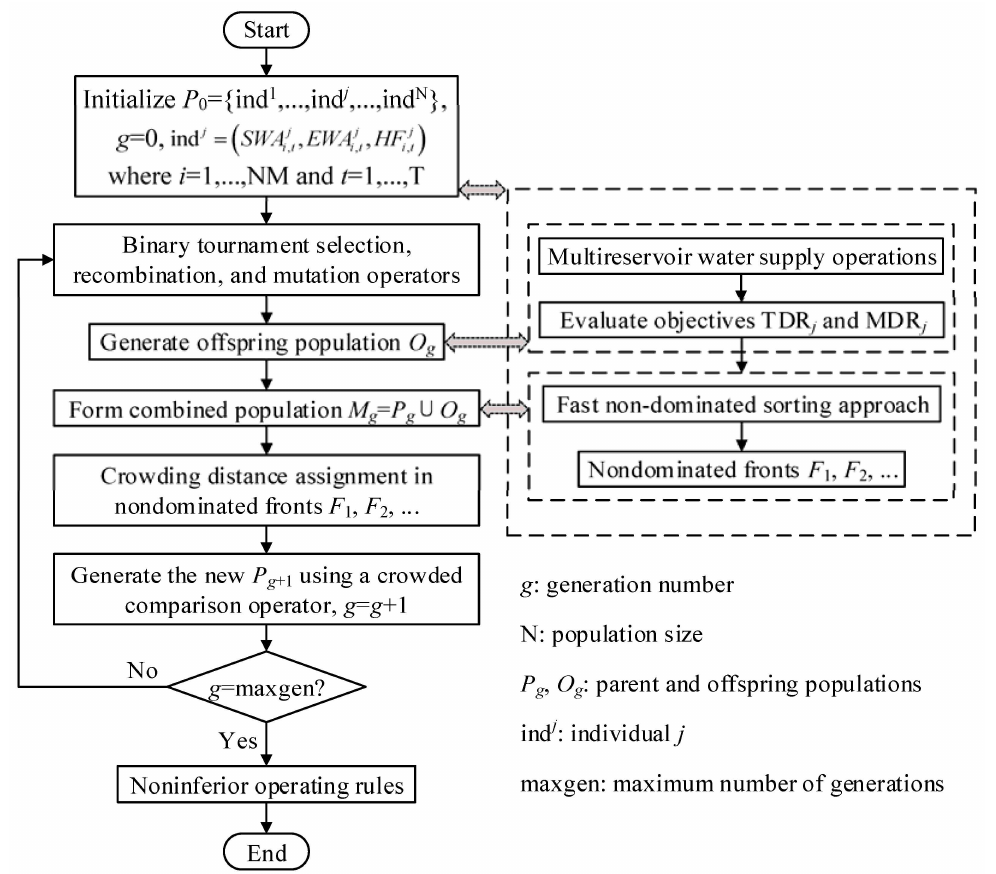
Figure 3. Flowchart to optimize a multireservoir water supply system using the